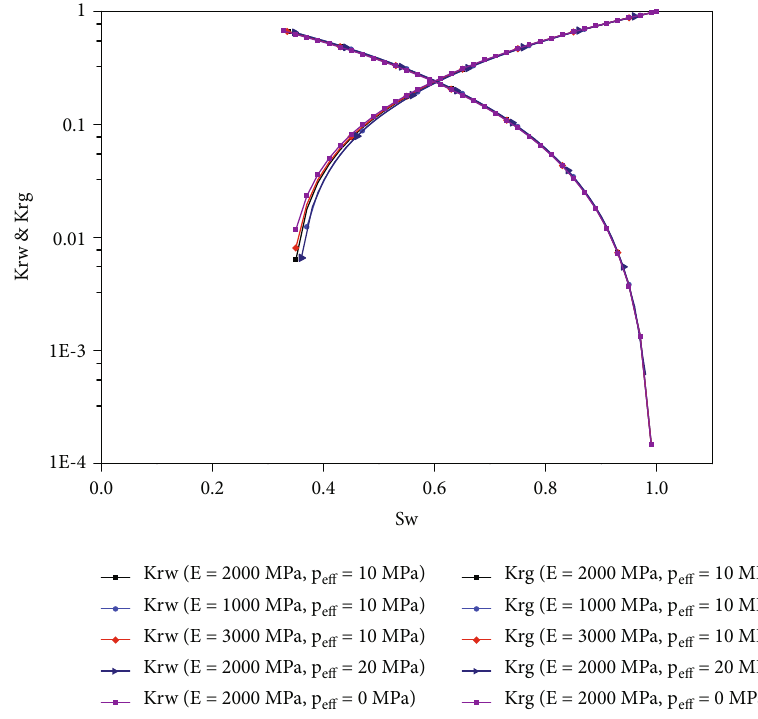
Figure 5: Relative permeability curve under di ff erent elastic modulus and e ff ective stress.